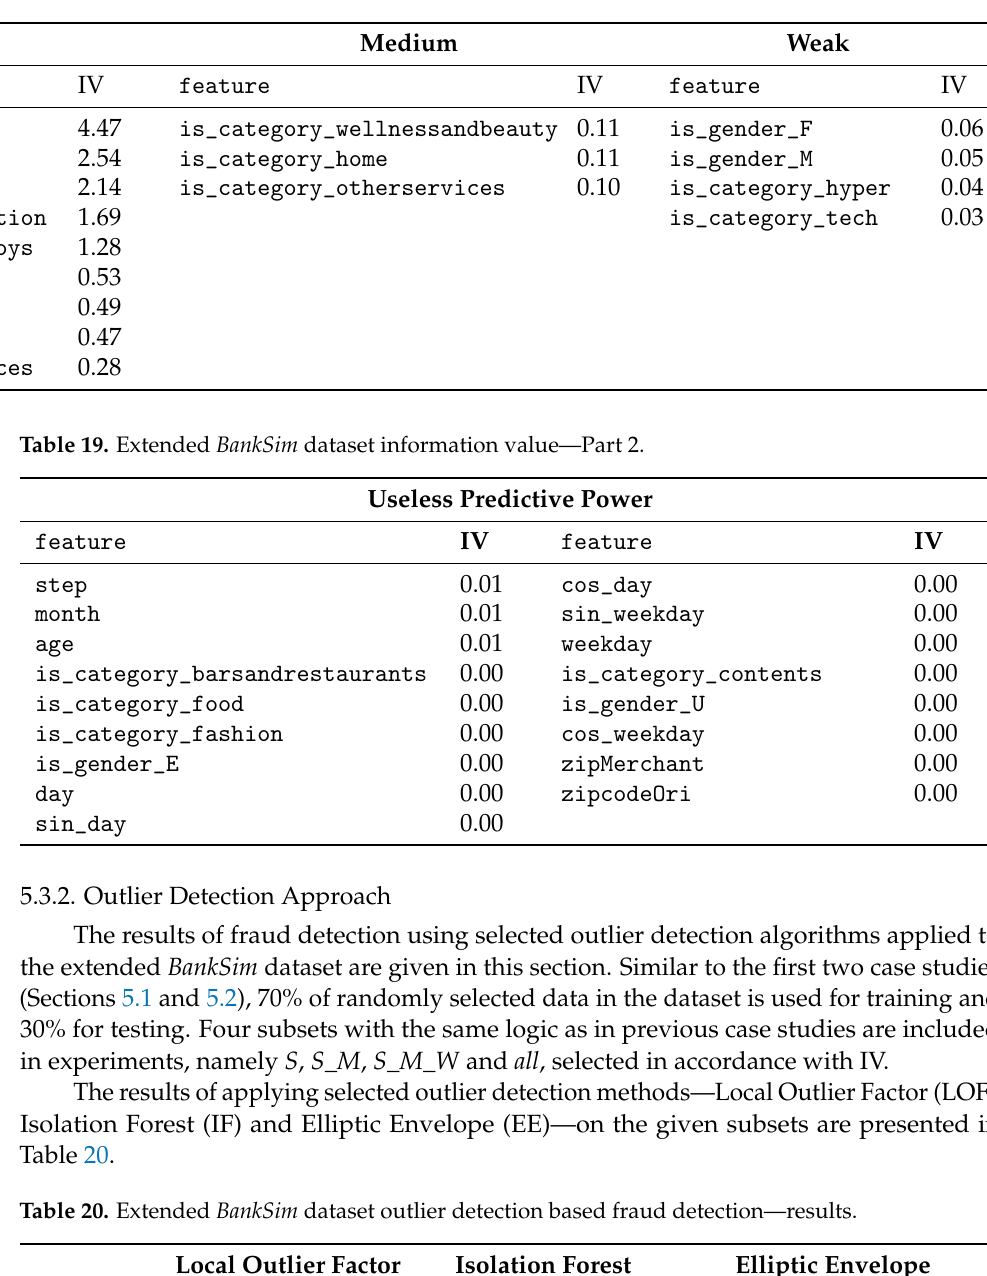
Table 18. Extended BankSim dataset information value—Part 1.